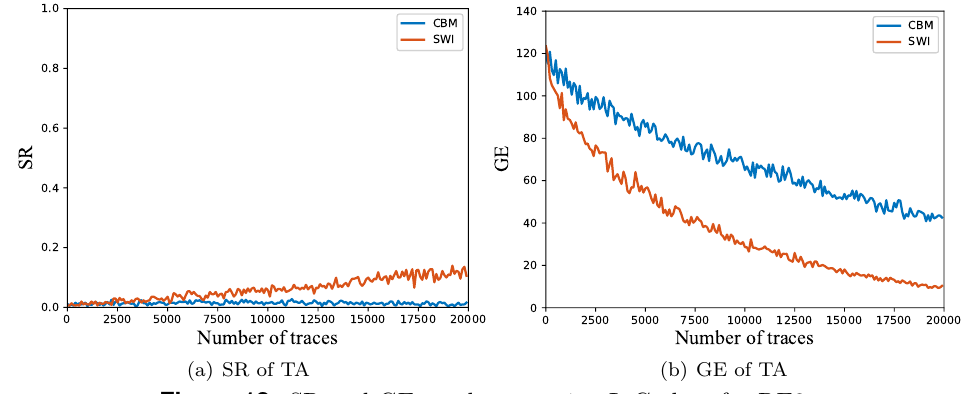
Figure 12: SR and GE results targeting L Gadget for